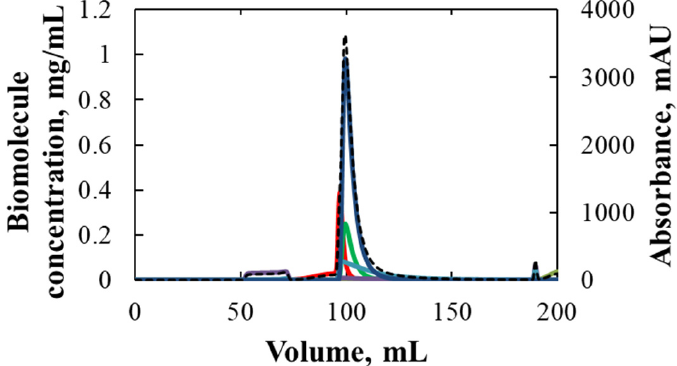
Figure 14. In silico optimization as performed for the industrial in-development process. The black dashed line refers to the absorbance, line colors as in Figure 11.